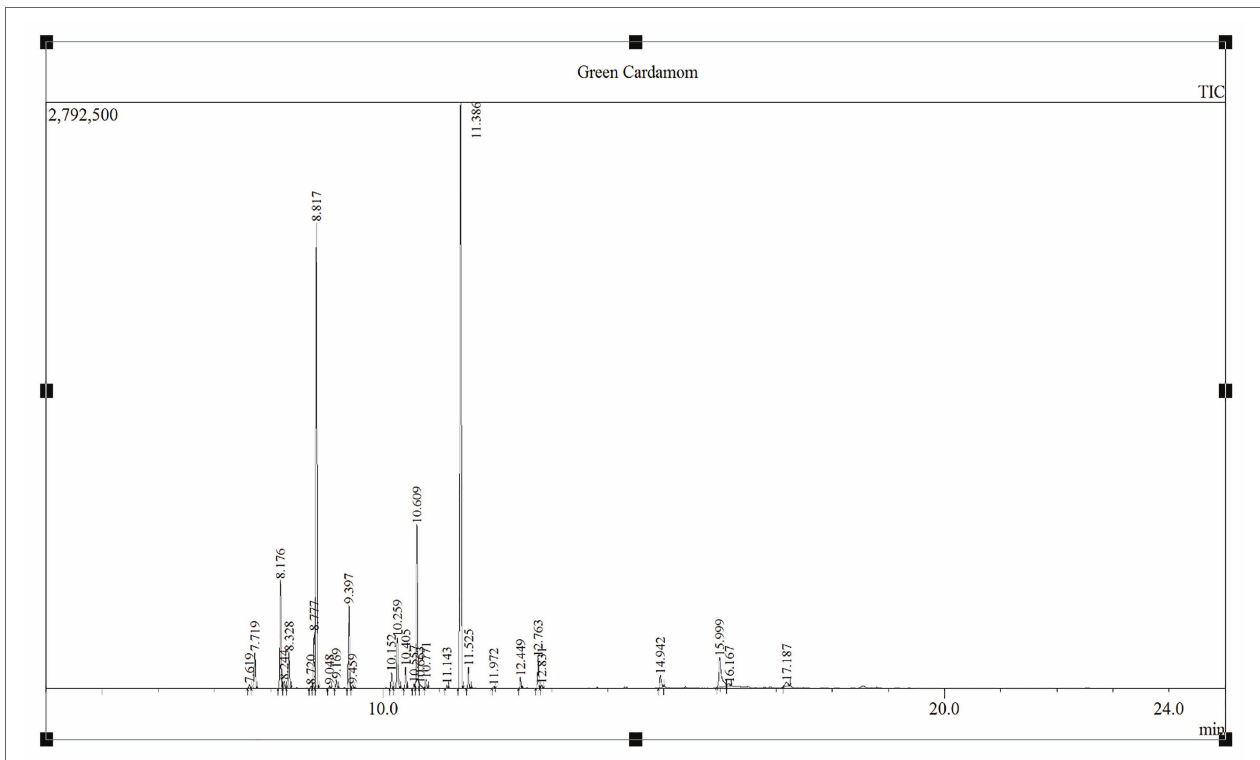
FIGURE 1 | The chromatogram elaborating GCEO bioactive compounds analyzed by the GC-MS (Shimadzu GC 2010 Plus and GCMS-TQ8040) through Shimadzu SH-Rxi-5Sil MS column (30 m long, 0.25 mm ID, 0.25 μ m coated film).